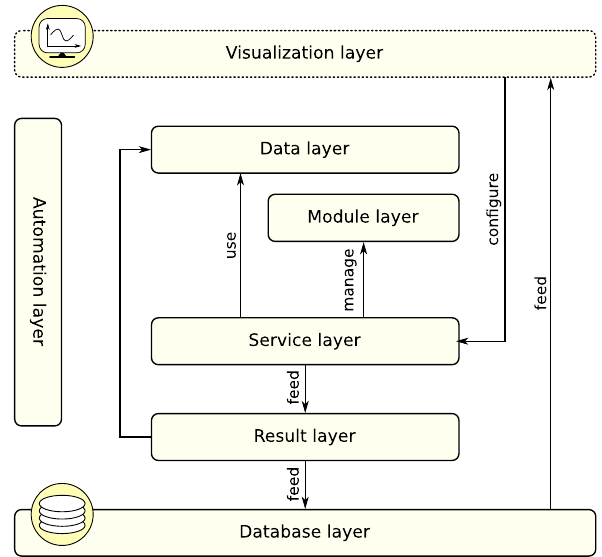
Fig. 4 The layered structure of the PARTONS framework. The Visual- ization layer, allowing users to launch computations from a visualizing interface, is not available in the first release of